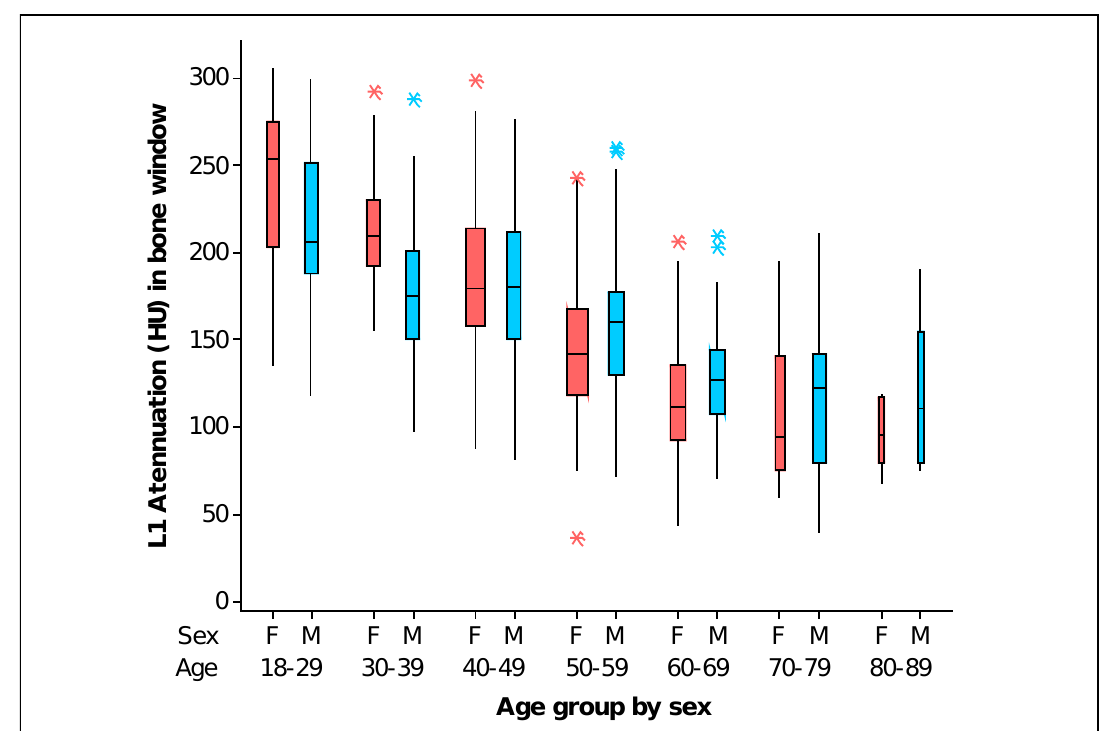
Figure 5. Box plots of the L1 trabecular attenuation (HU) measurements in the bone window (B) of the study sample ( n = 454) grouped by sex (F , female, red boxes; M, male, blue boxes) and by age (the width of the boxes is proportional to the sample size, the height of the boxes represent the distance between the first and third quartiles, the whiskers extend from either side of the boxes represent the ranges for the bottom 25% and the top 25% of the data values, and the outliers are marked with an asterisk on the boxes in each group). Table 4. L1 trabecular attenuation (HU) in bone window for men ( n = 211) and women ( n = 243) grouped by age.